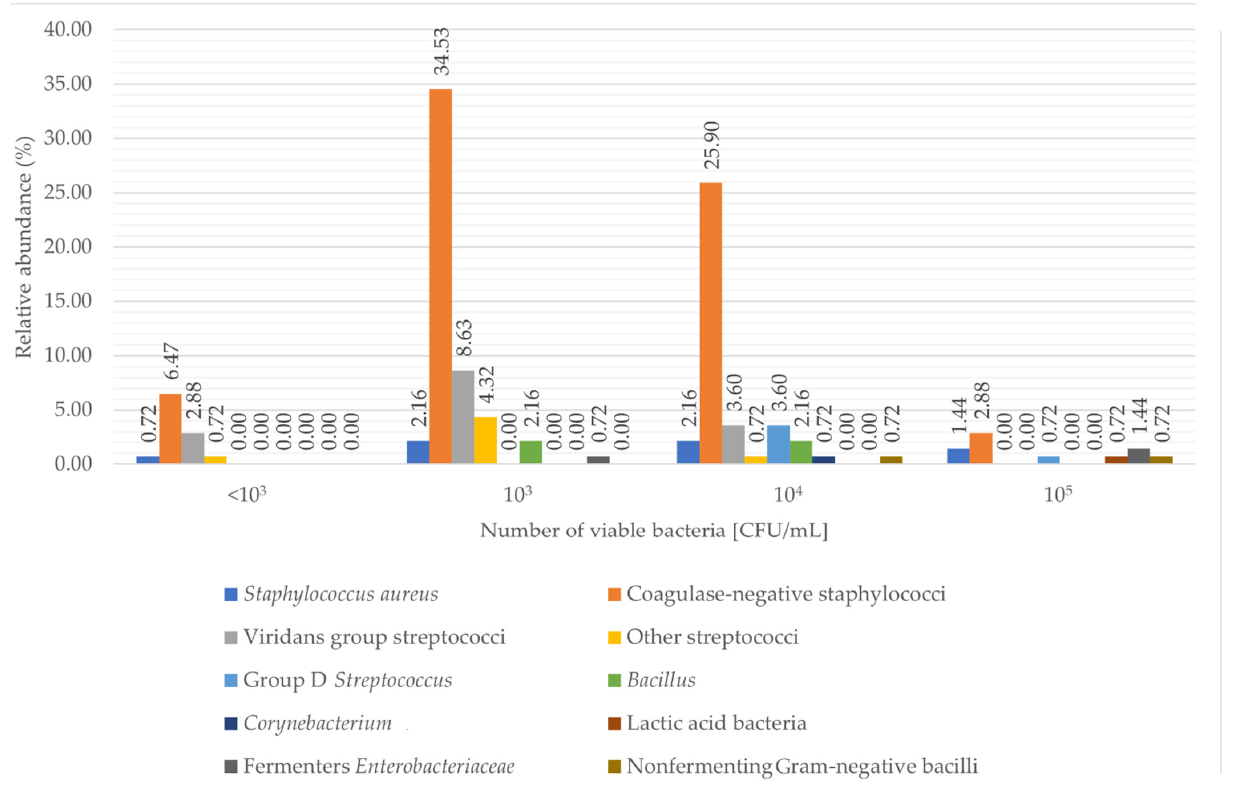
Figure 2. Quantitative results of detected groups of microorganisms in 139 milk samples. The data are presented as a percentage of samples with a certain number of viable bacteria. We found 93.52% of samples without growth of Staphylococcus aureus , 30.22% without coagulase-negative staphylococci, 84.89% without viridans group streptococci, 94.24% without other streptococci, 95.68% without group D Streptococcus , 95.68% without Bacillus , 99.28% without Corynebacterium , 99.28% without lactic acid bacteria, 97.84% without fermenters Enterobacteriaceae , and 98.56% without nonfermenting Gram-negative bacilli (data not shown in figure). Table 3. Microbiological findings in 139 breast milk samples from